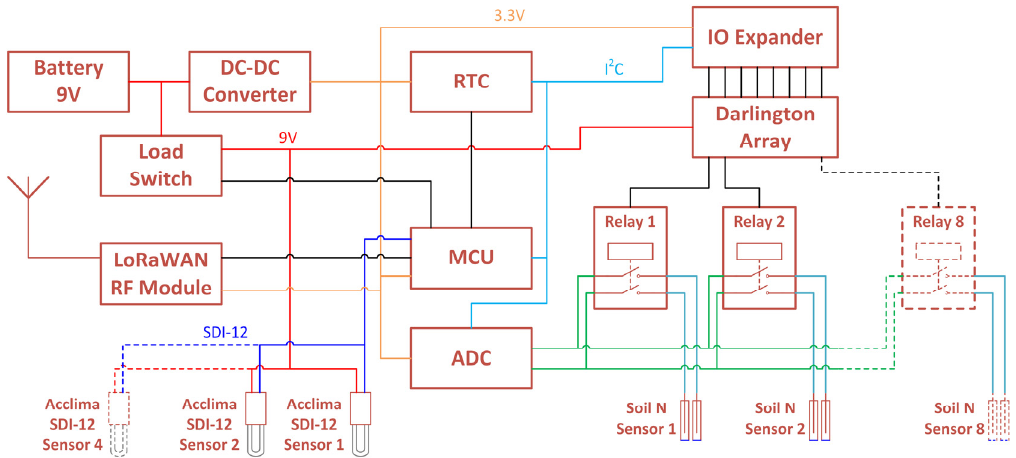
Figure 5. Design overview of IoT soil sensor node.